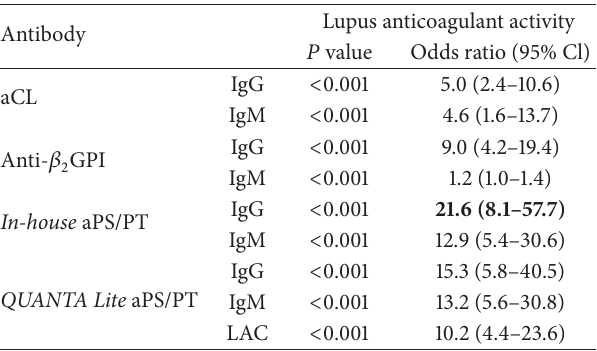
Table 3: Association between the presence of antiphospholipid antibodies and LA activity.